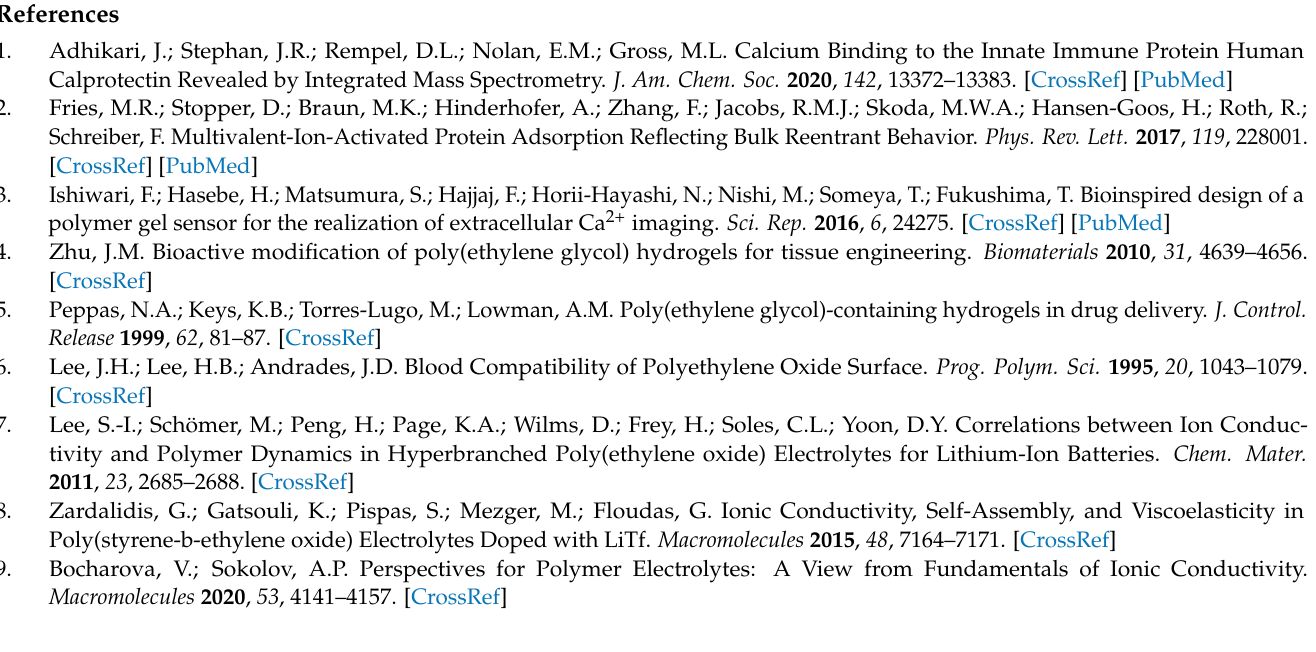
Figure S2: Values of molecular brightness of free OG514 as a function of salt concentration under different pH values; Figure S3: The molecular brightness of OG514 attached at the chain-end of PEO40k (OG514-PEO40k) as a function of pH value in the solution; Figure S4: The velocity of the PEO40k single chain as a function of the strength of the e-field in different salt solutions; Figure S5: Correlation function of the PEO40k sample under the e-field and salt-free condition inside the sample cell with hydrophobic walls; and Figure S6: Temperature of the sample as a function of the e-field strength. Table S1: Hydrodynamic radius, electrophoretic mobility and effective charge of the PEO40k sample in aqueous solution with different alkali chloride